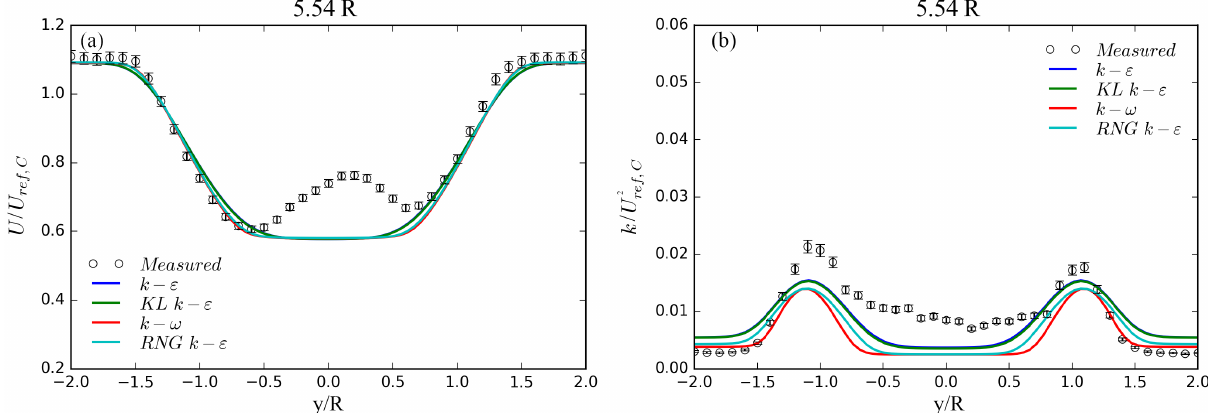
Figure 13. (a) Normalized axial velocity and (b) normalized turbulence kinetic energy computed for the two in-line model wind turbines (case C2) at x/R = 5 . 54 downstream of the first wind turbine. Different turbulence models are used along with the undistributed